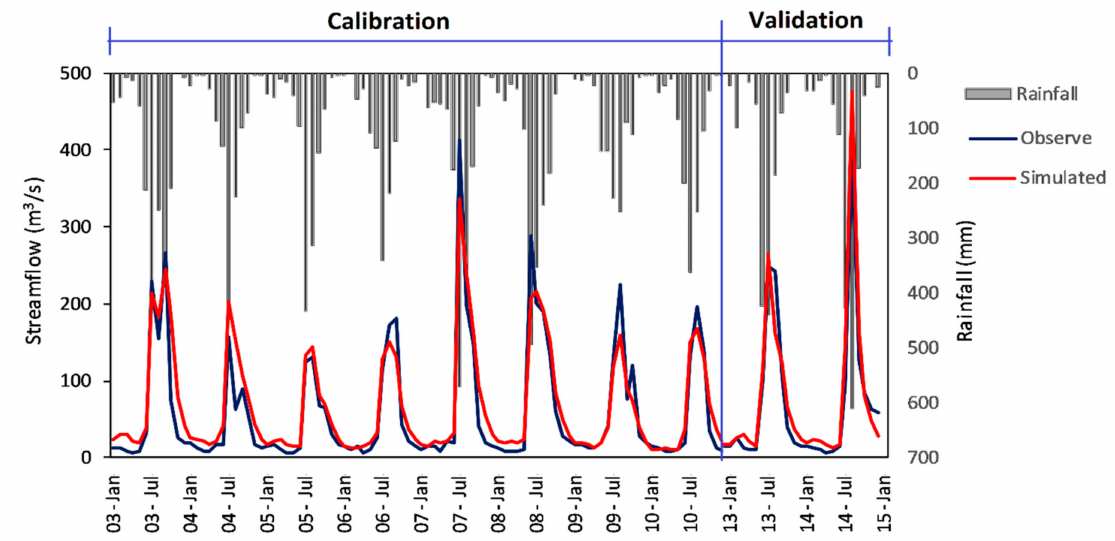
Figure 3. Comparison of observed and simulated streamflow data at the Chepang station.